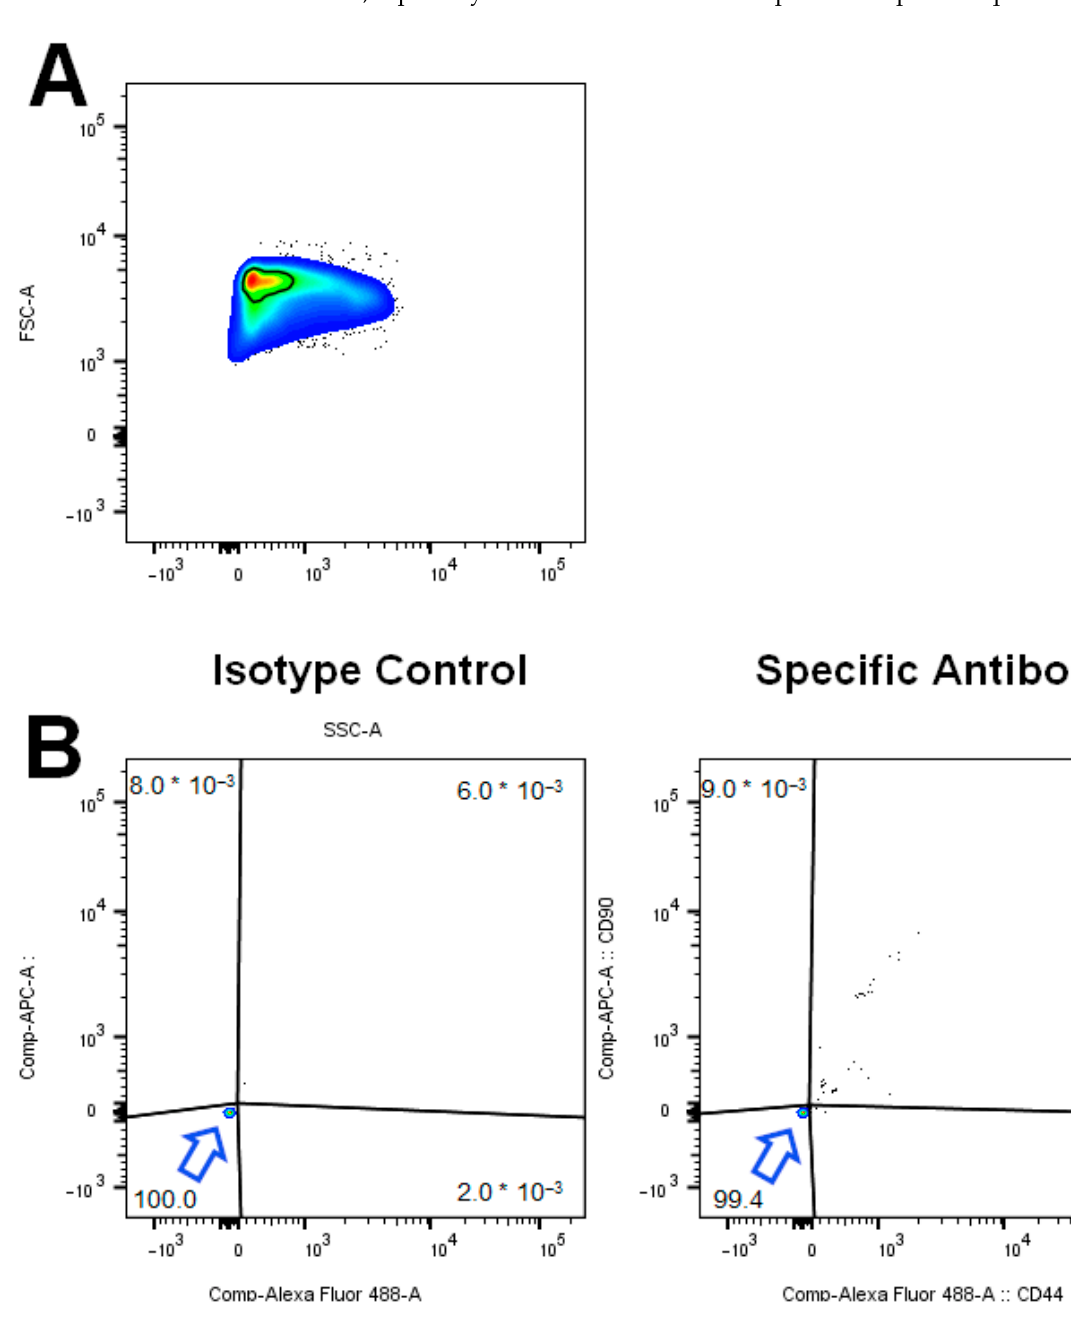
Figure 6. ( A ) Forward Scatter/Sideward Scatter Plot for cells isolated from adipose tissue. The gated cell population is shown. ( B ) Cells stained with isotype control antibodies are in the lower left quadrant of an APC/AlexaFluor488 Plot. For isotype control cytometry 50,000 events were counted (left). After staining with specific antibodies for CD44/CD90, nearly 0.5% of cells are positive for CD44/CD90. Arrows point to the main population. For specific antibody cytometry 100,000 events were counted. One of four measurements is shown. (right).